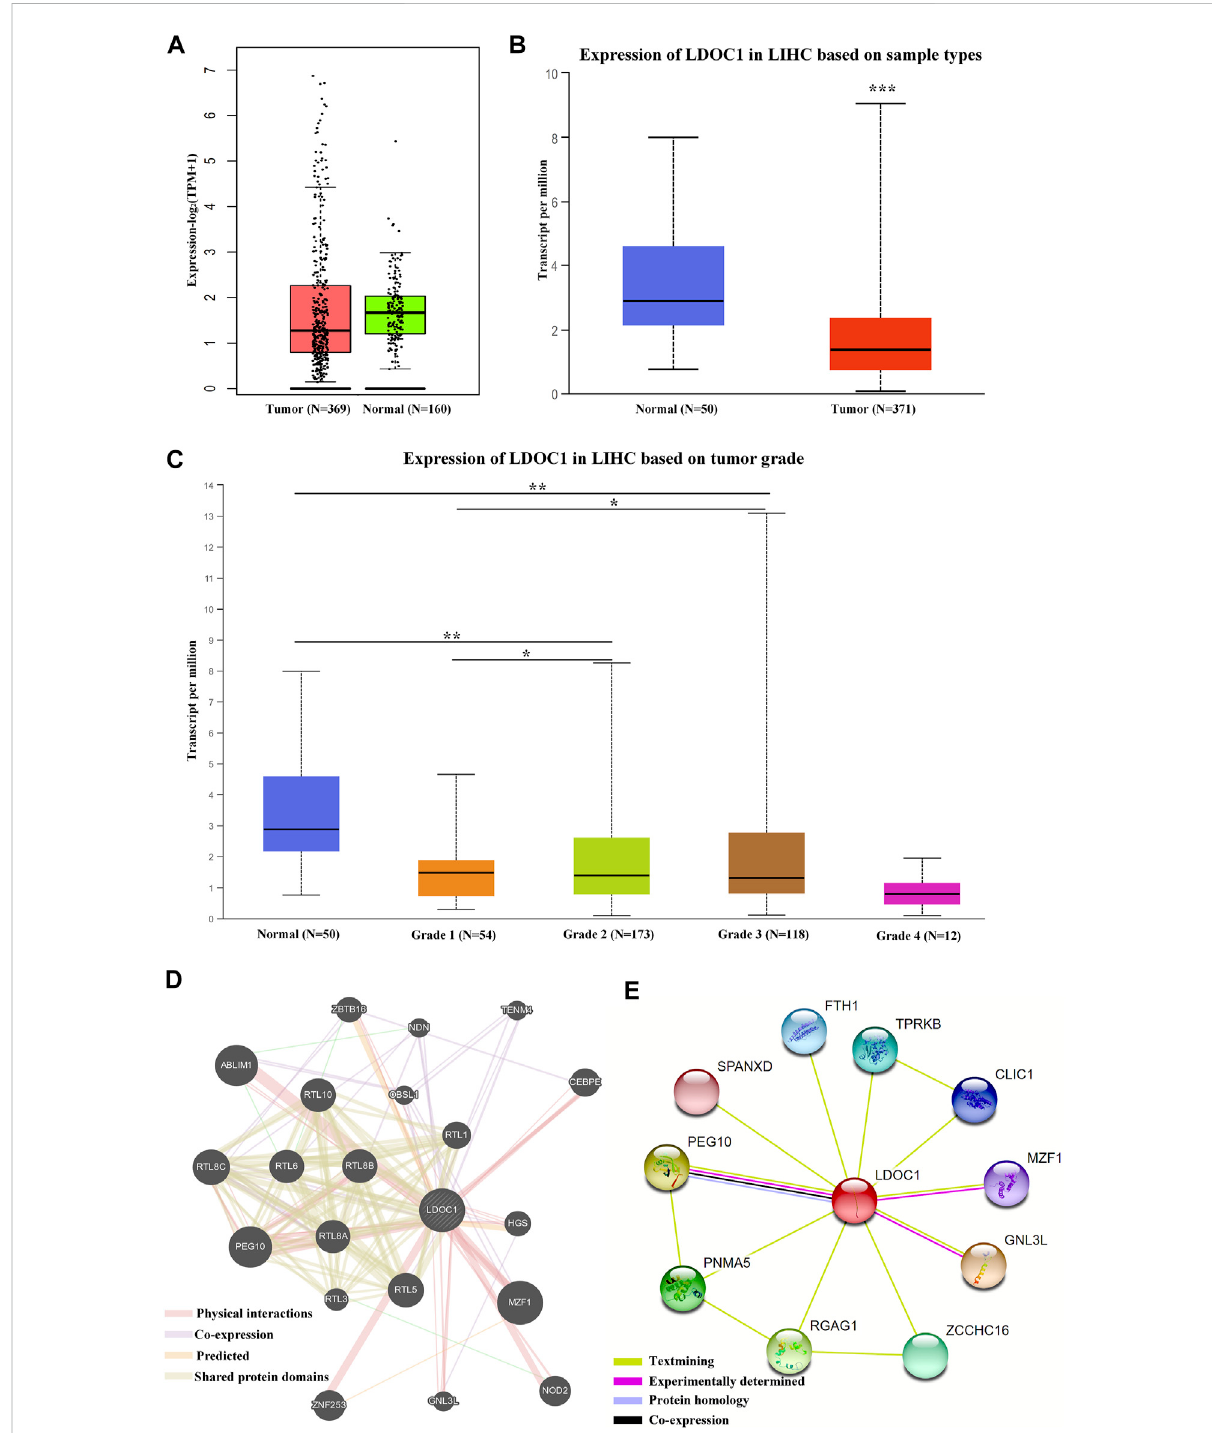
FIGURE 1 Expression levels and interaction networks of LDOC1. (A) Expression levels of LDOC1 in tumor and normal tissues. (B) Transcript levels of LDOC1 in tumor and normal tissues. (C) Expression levels of LDOC1 in different grades. (D) interaction network for LDOC1 and other genes. (E) Interaction network for LDOC1 and other proteins. * p < 0.05, ** p <